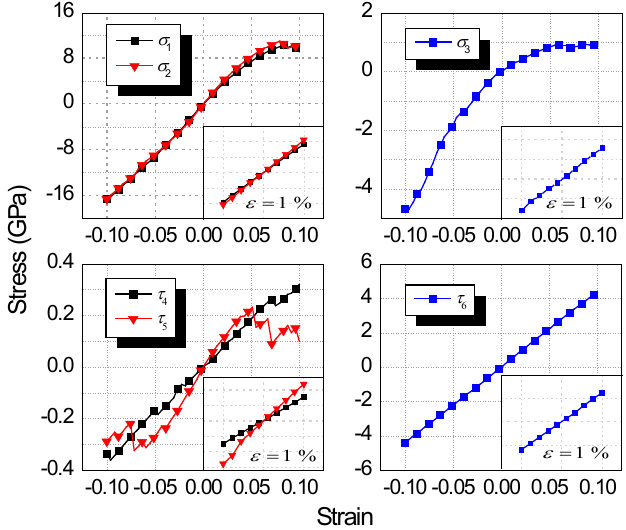
Figure 4. Typical stress–strain behavior for hydrated Ca-montmorillonite.